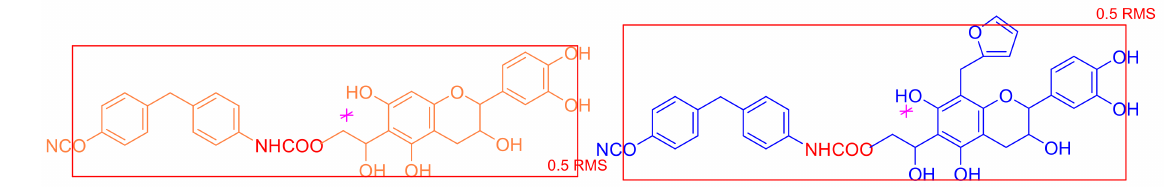
Figure 3. Tannin-based polyurethane with an isocyanate group reaction on a glyoxal group previously reacted using a flavonoid tannin unit